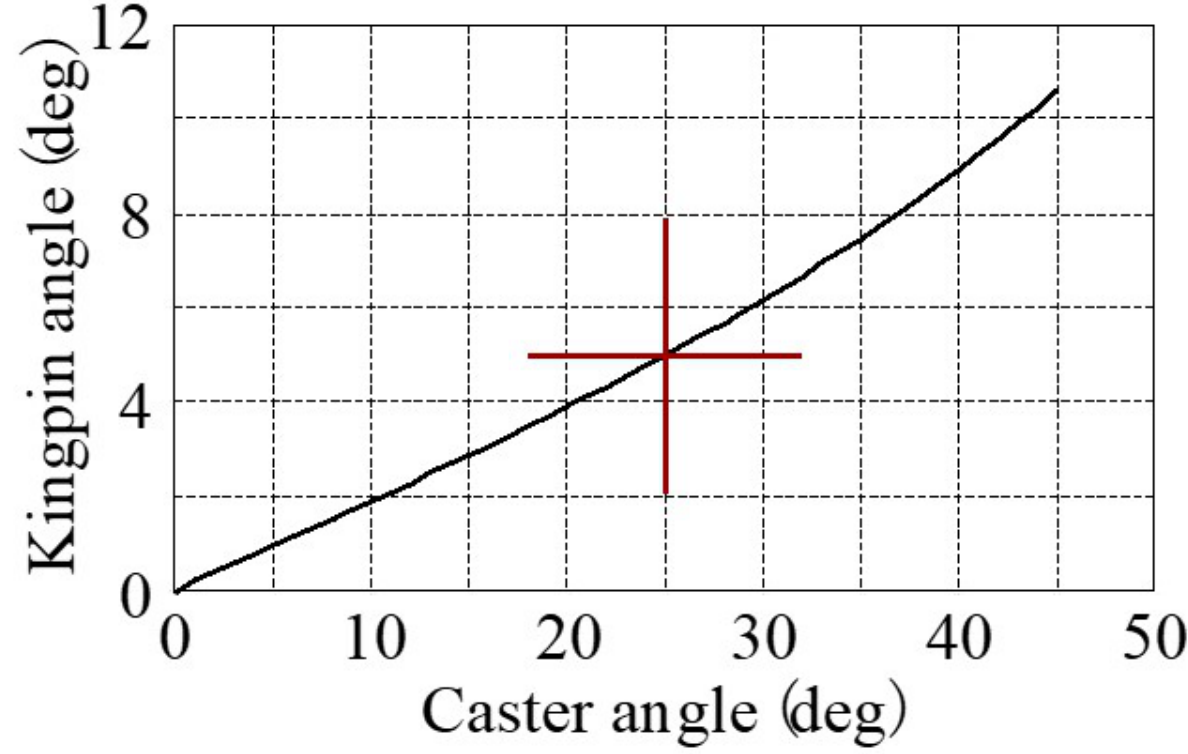
Figure 9. Steering axis to minimize M s by F z on zero roll condition.